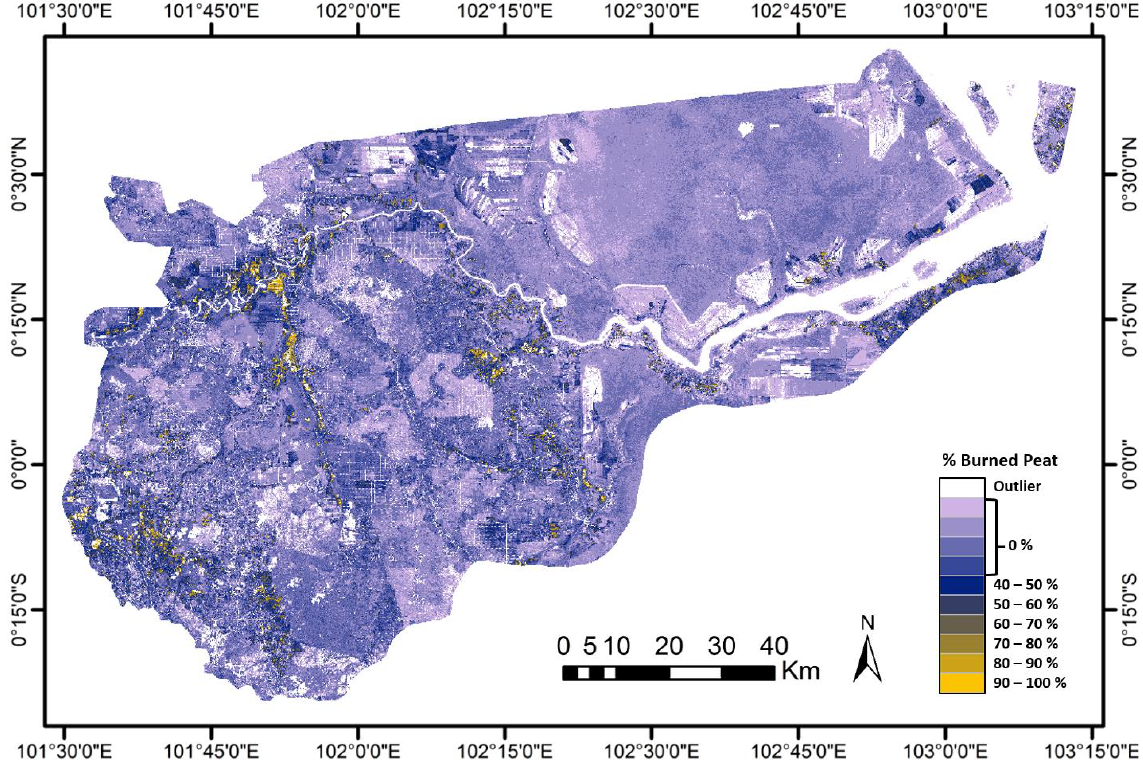
Figure 8. Burned peat fraction imagery derived from PCA spectral using local